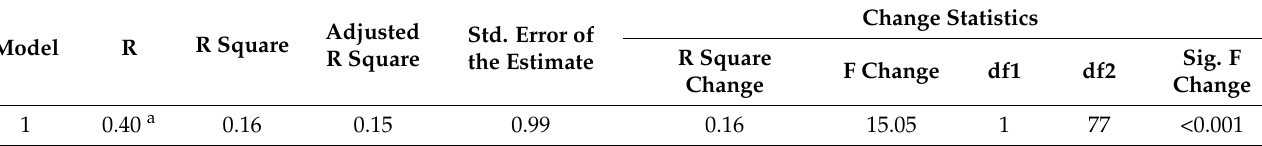
Table 8. Model Summary.